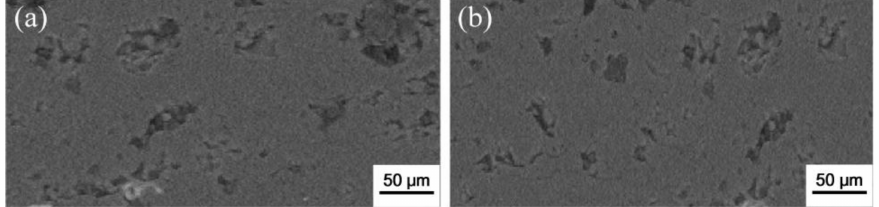
Figure 8. Pore structure of alumina coating under different corrosion time: ( a ) 12 h; ( b ) 48 h.